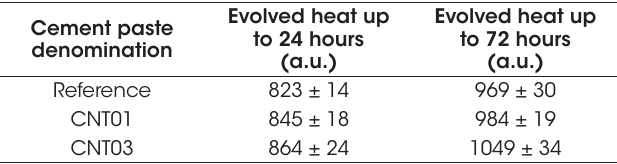
Evolved accumulated heat, in arbitrary units, for each cement paste composition